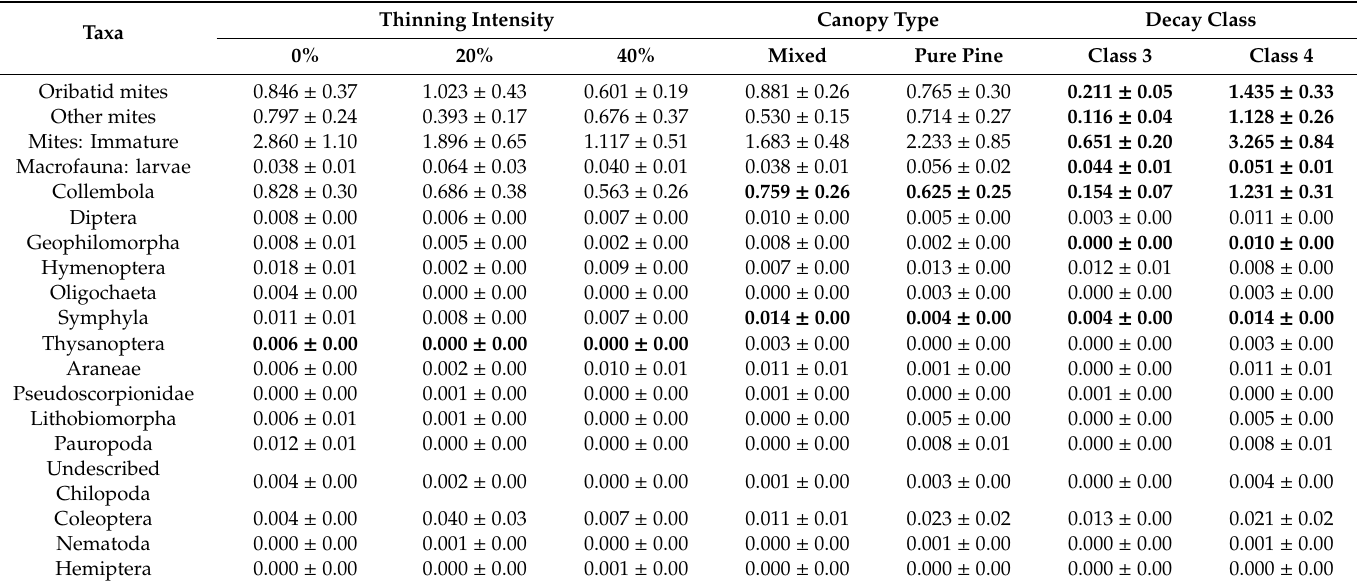
Table 4. Mean abundances ± SE per gram of sample of each taxonomic group in di ff erent treatments of thinning intensity, canopy tree species, and decay class (taxonomic groups with significant di ff erences in bold, n = 36, p < 0.05).